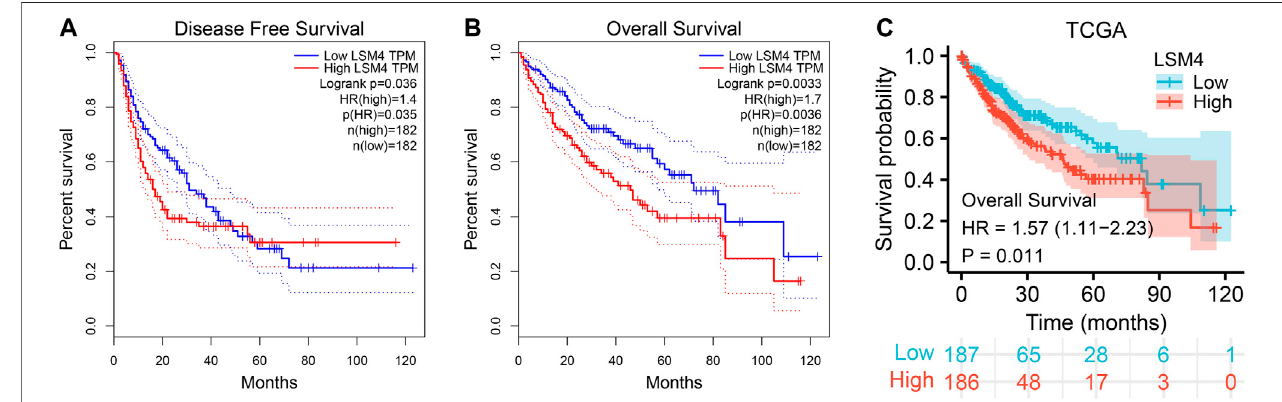
FIGURE 7 | Survival curves of overall survival (OS) and disease-free survival (DFS) in hepatocellular carcinoma. Kaplan – Meier curves of hepatocellular carcinoma patients OS and DFS in patients with different LSM4 expression based on GEPIA database (A – B) . Kaplan – Meier curves of OS grouped by LSM4 expression in hepatocellular carcinoma validated by TCGA datasets (C)